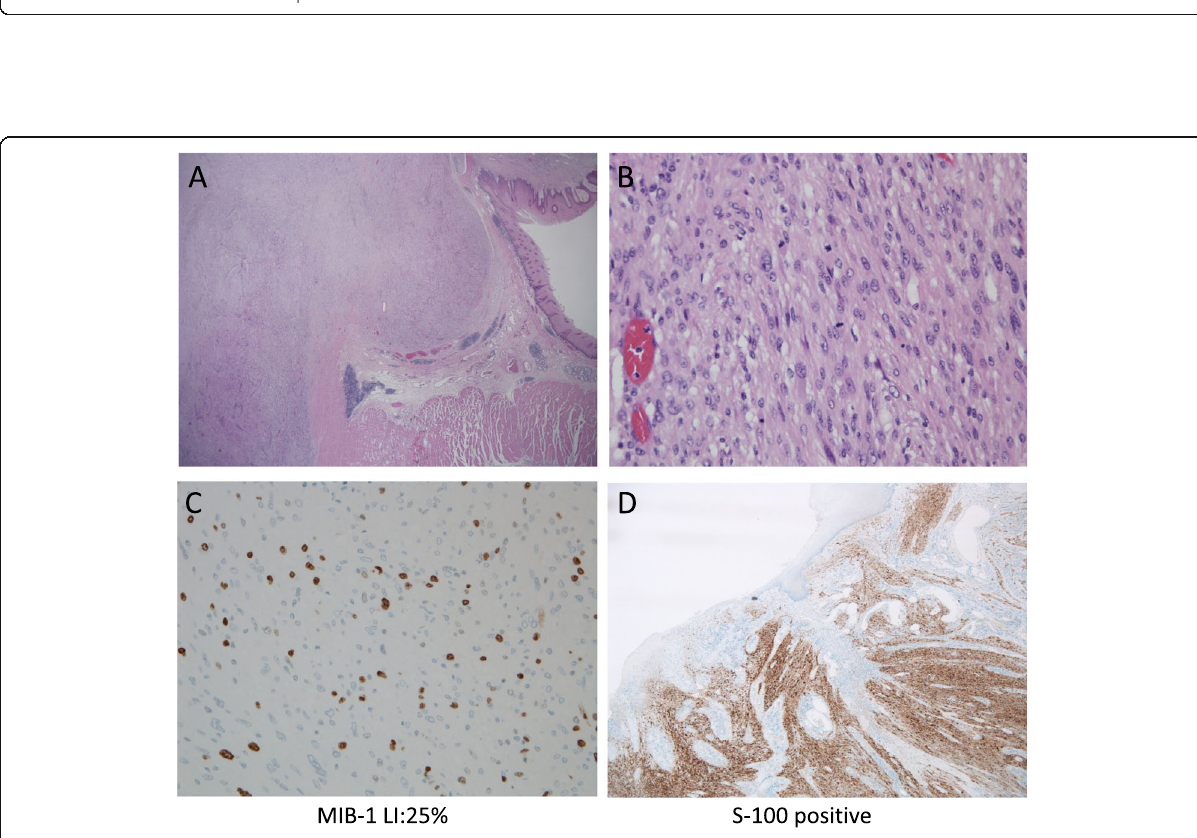
Fig. 4 a Macroscopic findings. The resected tumour was 75 × 45 × 45 mm in size. b A large bulging lesion with a degenerative necrosis was observed in the neck. c The raised part of the tumour was covered with normal mucosa.